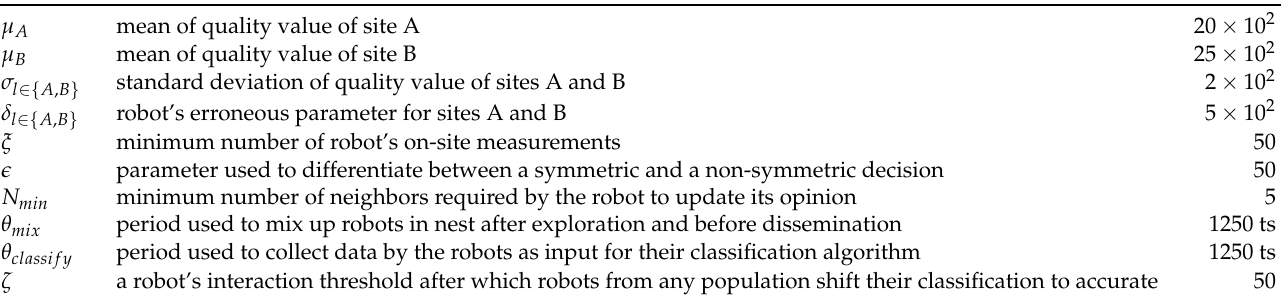
Table 1. The selected parameter values for both the basic and extended behavioral models.